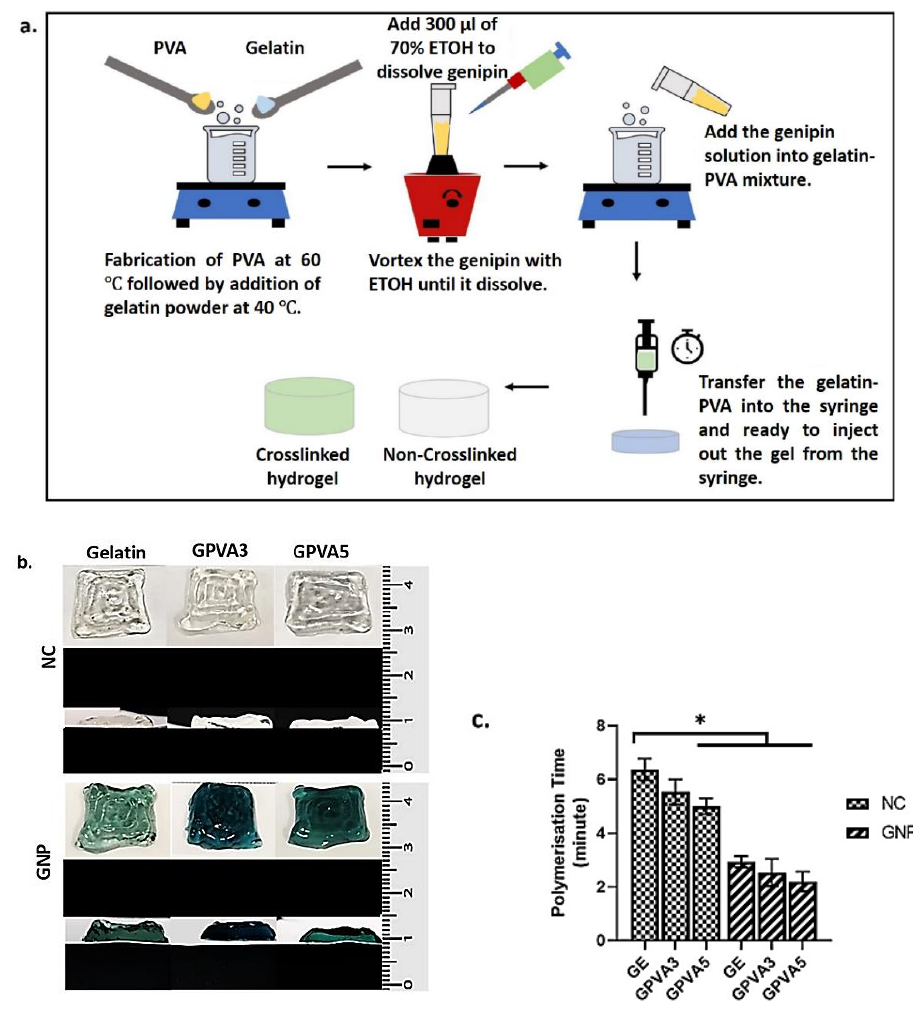
Figure 2. ( a ) Schematic of the hydrogel fabrication steps, ( b ) gross appearance (top view and cross- sectional) of hydrogel, and ( c ) polymerisation time for non-crosslinked and crosslinked hydrogels, where * indicates p < 0.05.